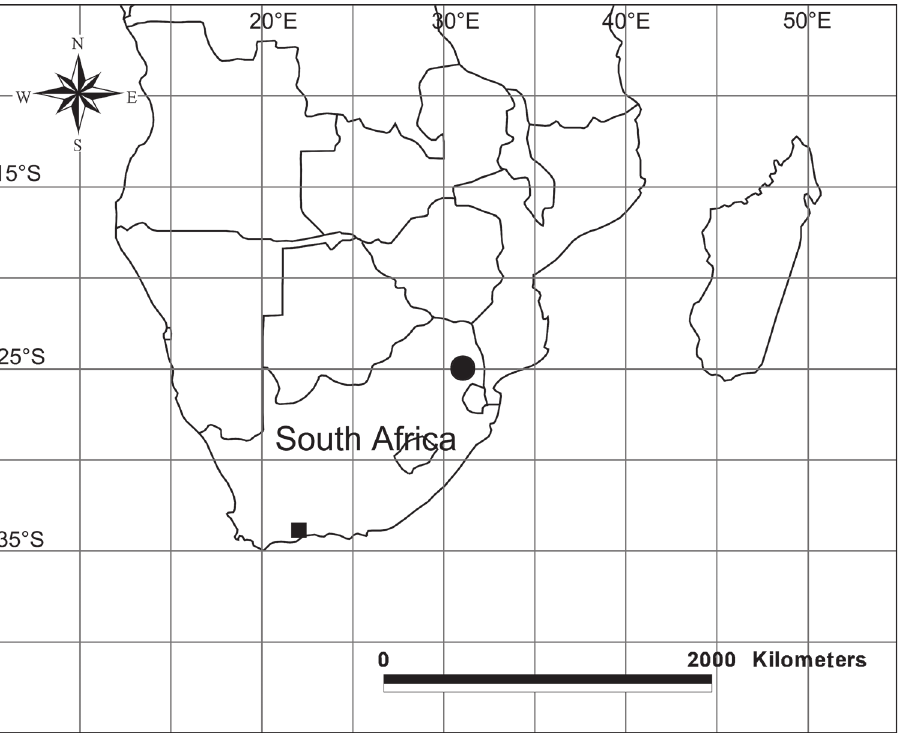
Figure 15. Locality records for Cangoderces lewisi (square) and C. globosa sp. n. (circle) in South Africa. Females of C. globosa sp. n. have a ball-shaped spermatheca (e.g. Fig. 7), which